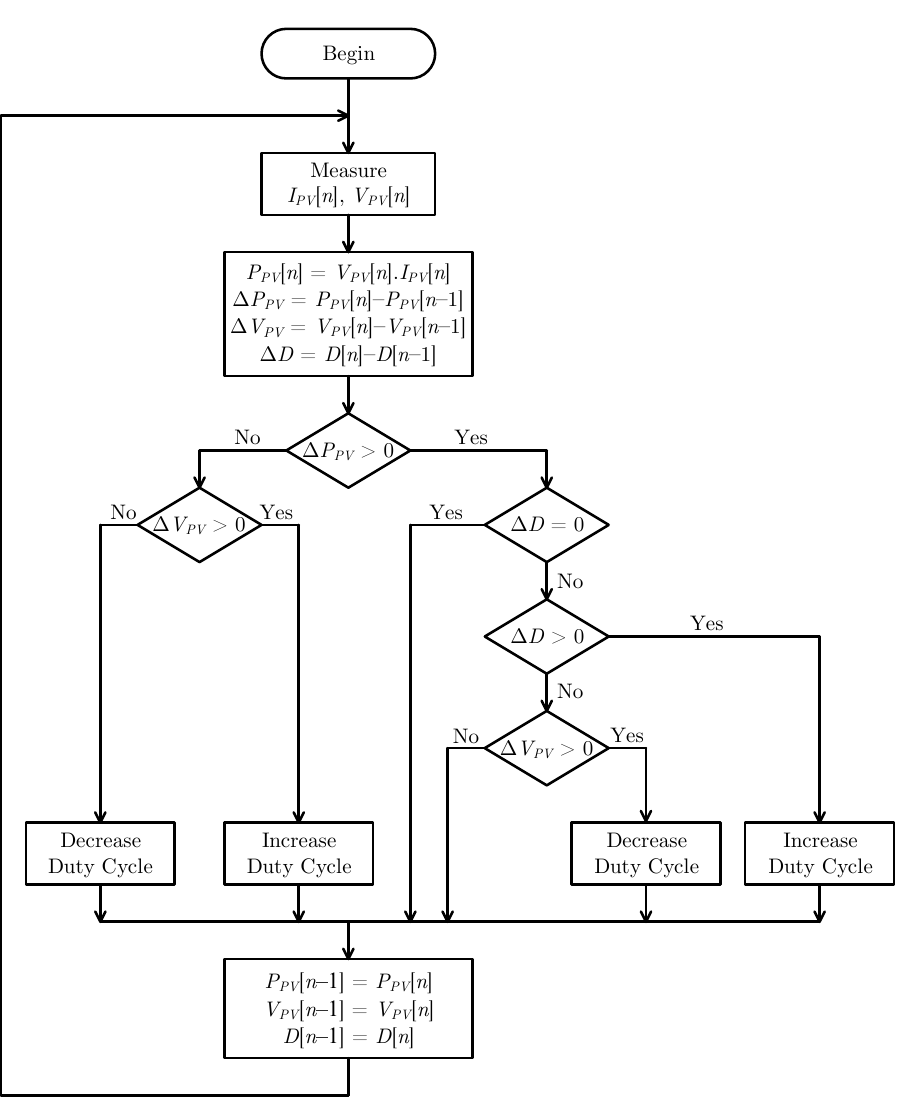
Figure 12. Proposed MPPT